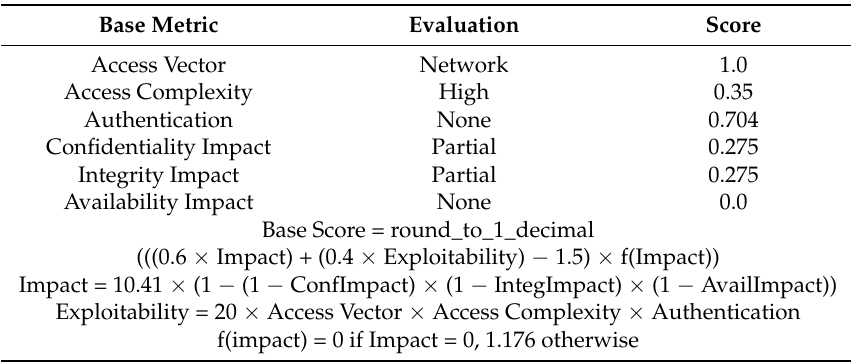
Table 2. CVSS Base Score.